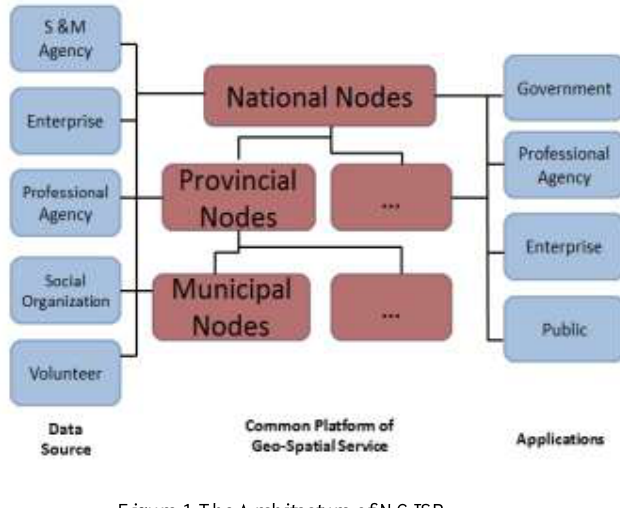
Figure 1 The Architecture of